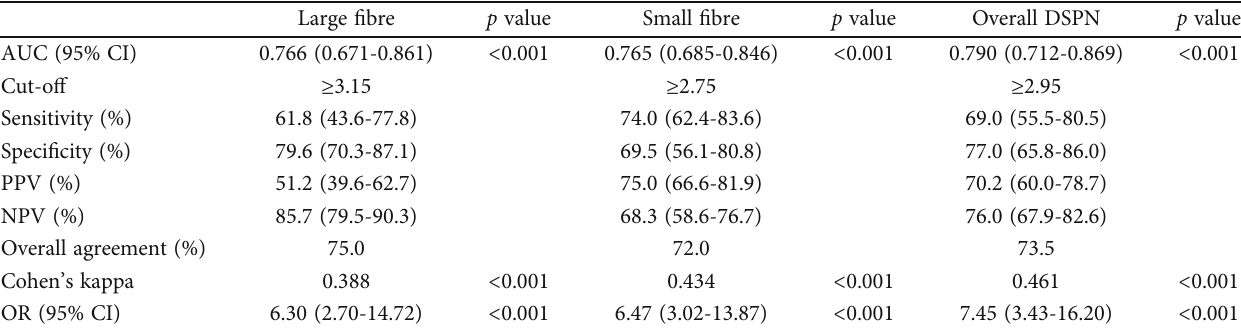
Table 3: ROC analysis for the evaluation of the diagnostic signi fi cance of AGEs (single measurement) for large fi bre impairment, small fi bre impairment, and overall DSPN.